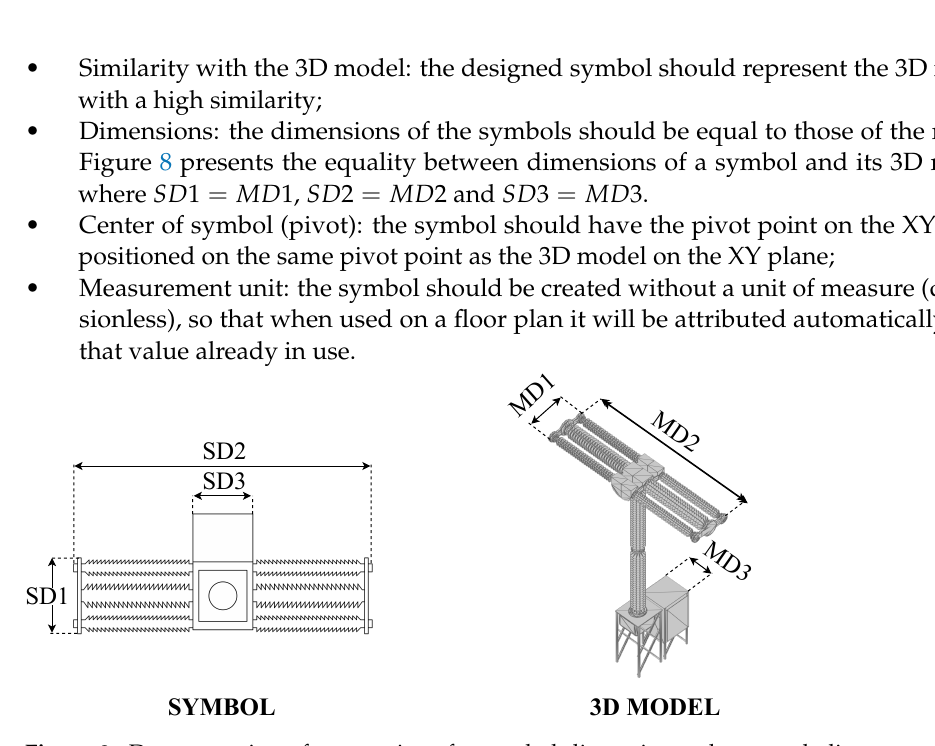
Figure 8. Demonstration of conventions for symbol dimensions where symbolic representation maintains the proportions of the 3D